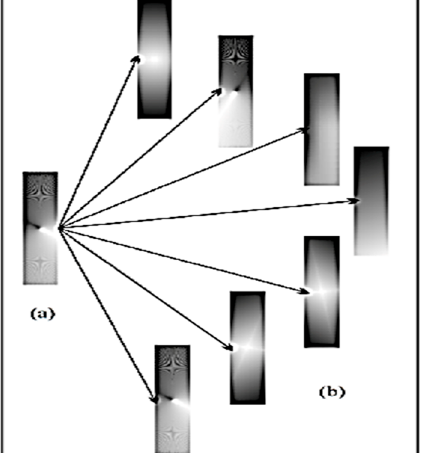
Figure 2. A single node of neural network.